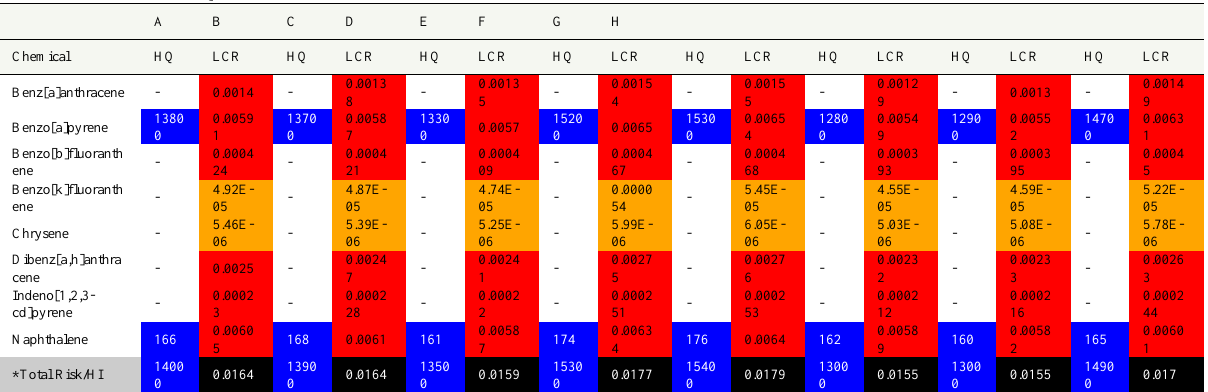
Table 8. LCR and HQ of PAHs